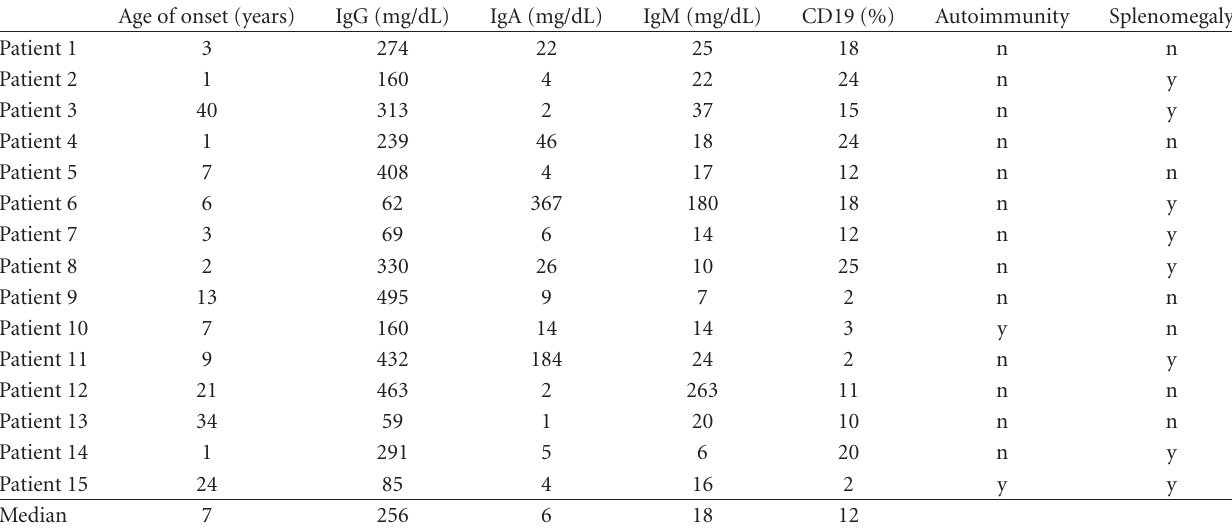
Table 1: Summary of the clinical and immunological features of CVID patients included in this study (age of onset, immunoglobulin serum levels at diagnosis, percentage of CD19 positive B cells, and presence/absence of autoimmune manifestations and